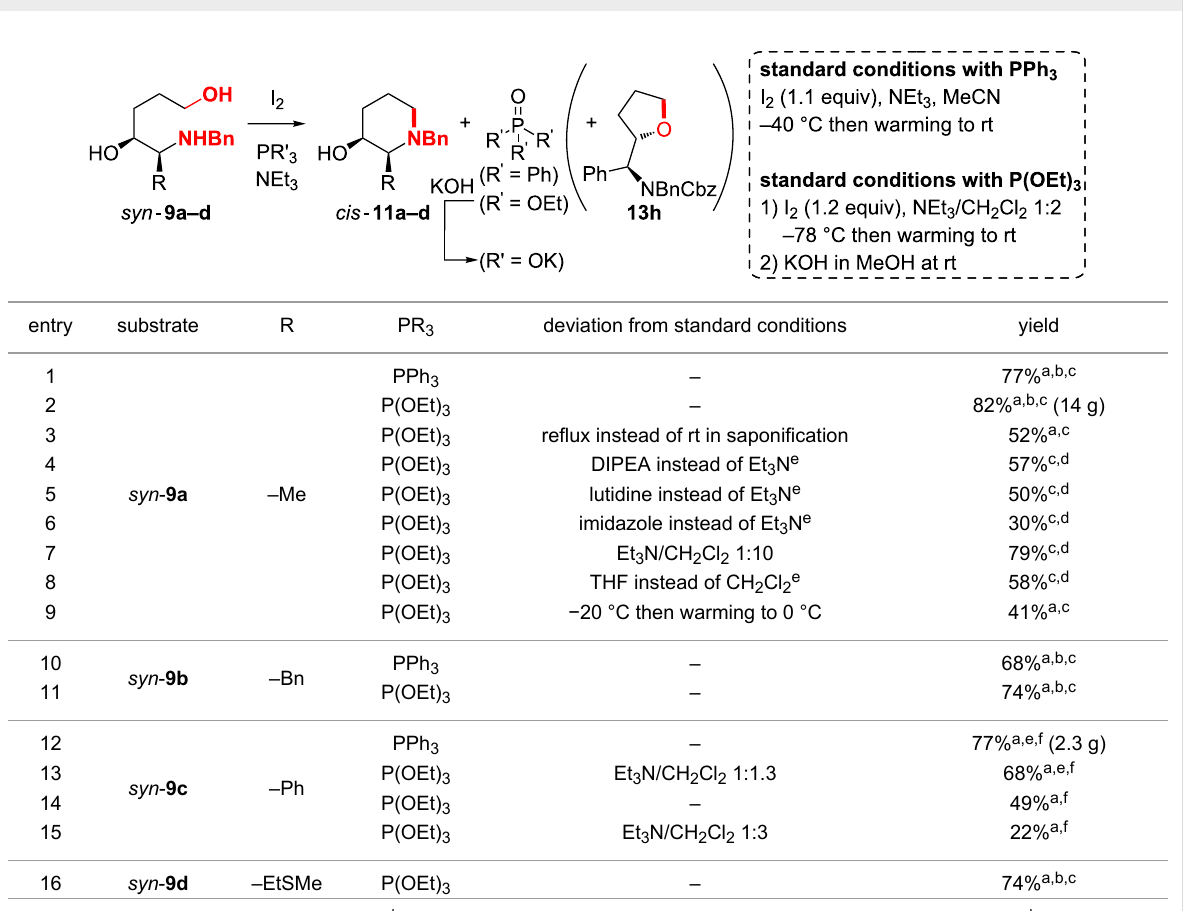
Table 2: Cyclodehydration of amino alcohols 9a–d to piperidinols 11a–d